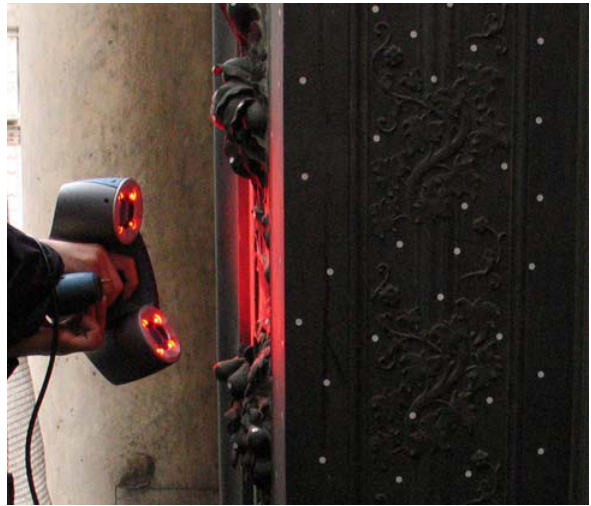
Figure 1. Handyscan system (Creaform); the target are used for self-positioninig, without any external tracking device